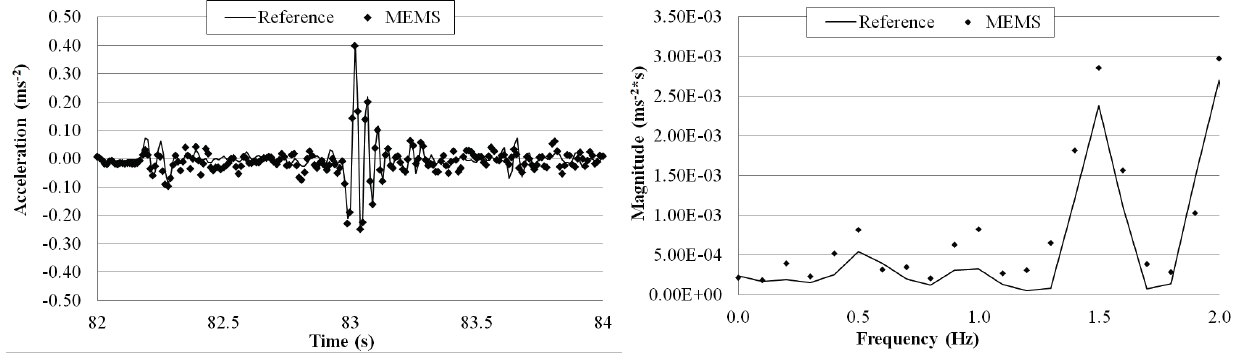
Figure 24. Comparison of measurements by the two sensors in time and frequency domains (0.5 Hz Periodic Wave Excitation).